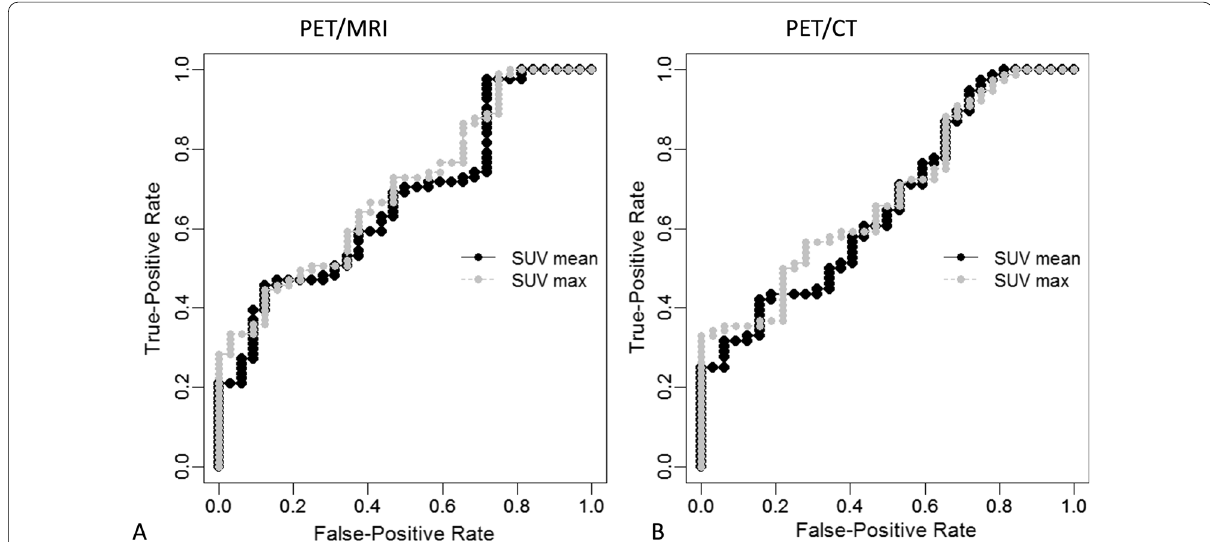
Fig. 1 Lesion-based ROC curve analysis of SUVmean and SUVmax values measured on PET/MRI and PET/CT for the detection of distant metastases and distant synchronous cancers. The area under the curve (AUC) for SUVmean and SUVmax measured on PET/MRI was 0.669 [0.562–0.776] and 0.698 [0.596–0.800], respectively. The AUC for SUVmean and SUVmax measured on PET/CT was 0.661 [0.550–0.772] and 0.682 [0.576–0.788], respectively. Delong’s test for 2 correlated ROC curves revealed that SUVmean and SUVmax values measured on PET/MRI and PET/CT did not differ significantly in terms of diagnostic capability ( p > 0.05)